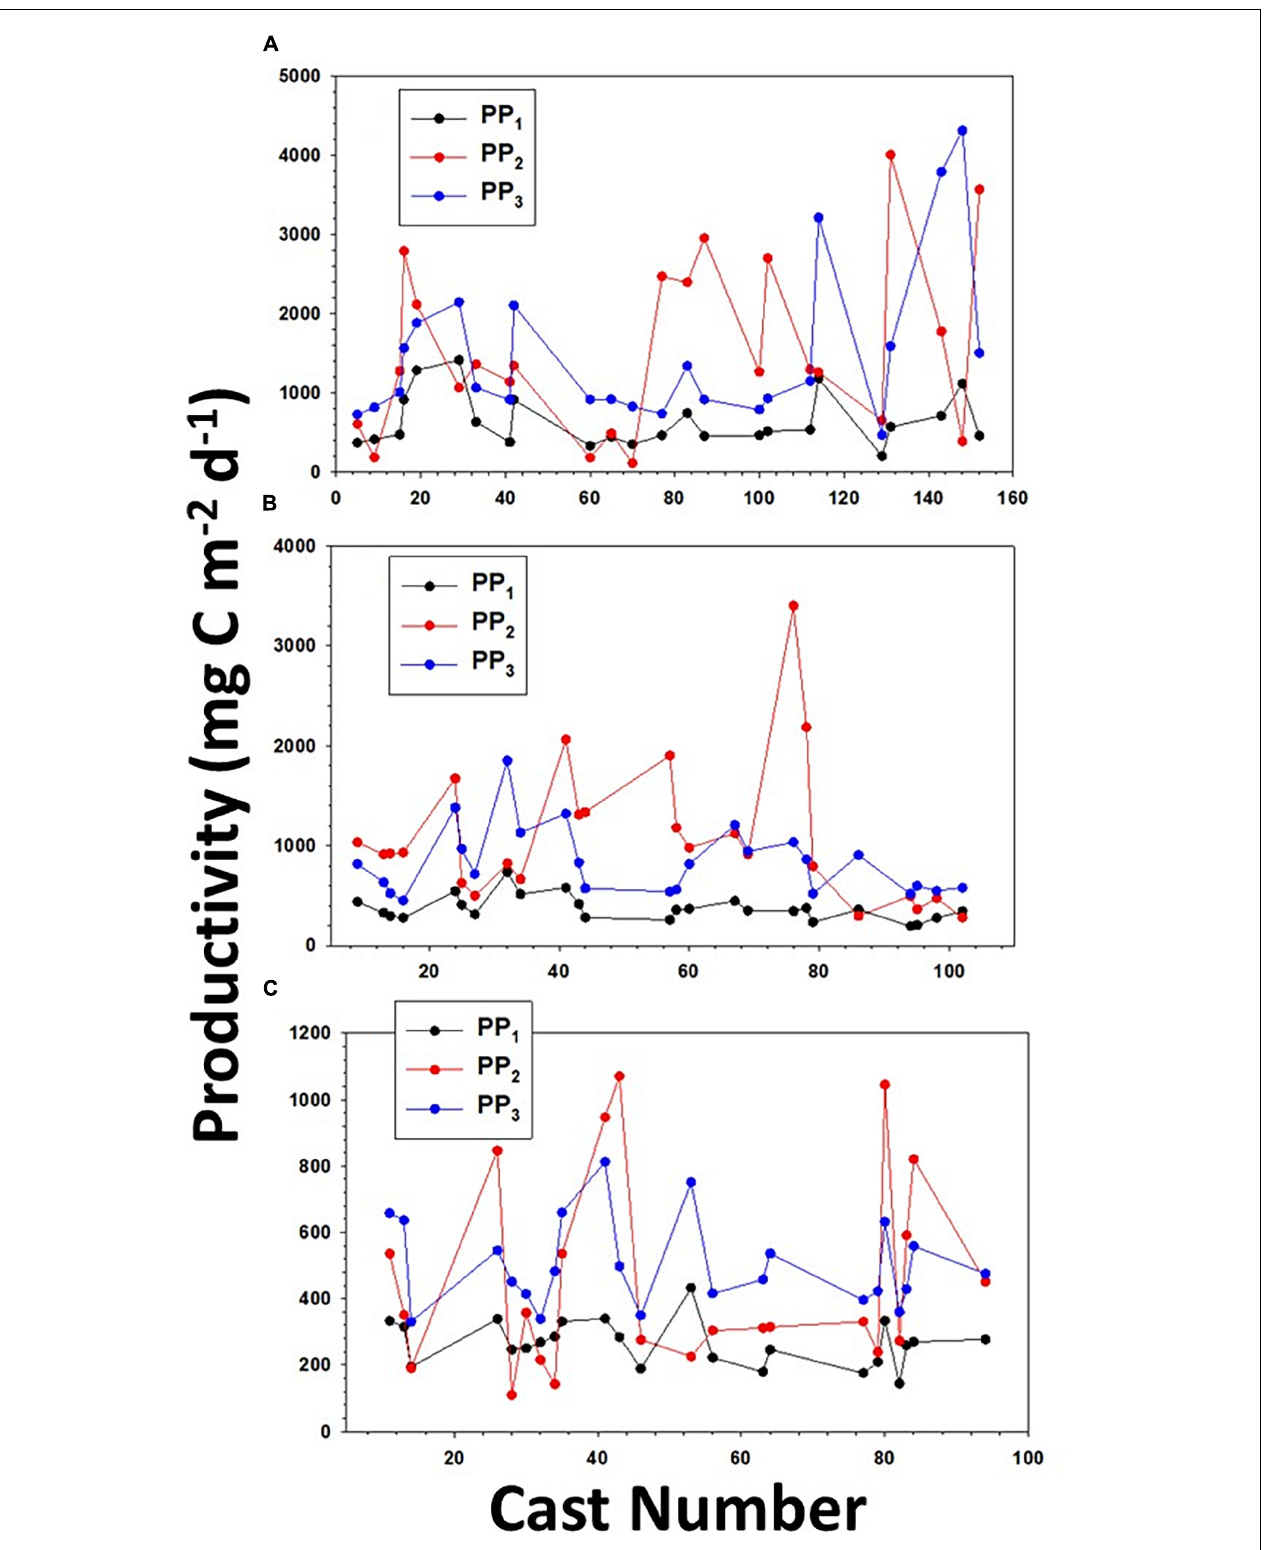
FIGURE 8 | The distribution of primary productivity determined by the vertically resolved productivity model (PP 1 ), 14 C-uptake (PP 2 ), and by the surface variable productivity model (PP 3 ) along (A) AR29, (B) RB1904, and (C) TN368.